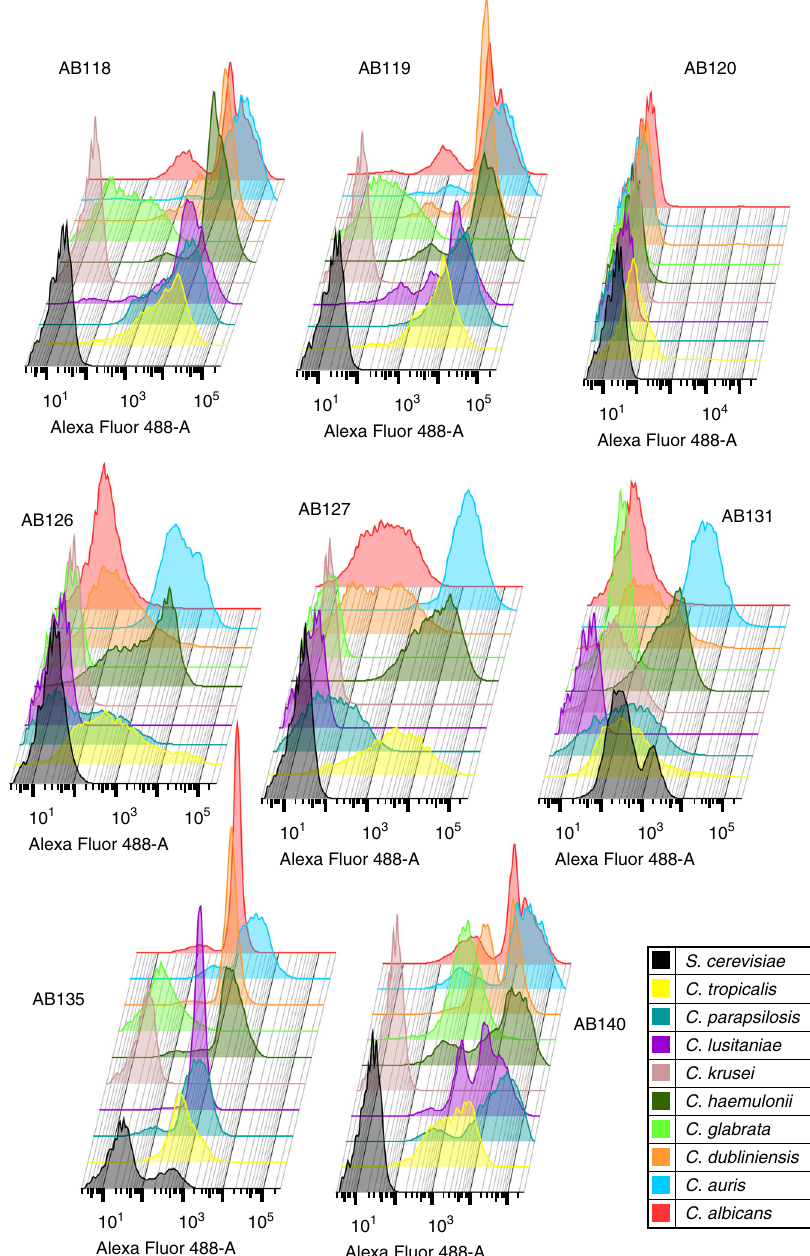
Fig. 6 Anti- Candida mAbs binding pro fi les to clinically relevant Candida species and S . cerevisiae . Representative FACS data from three separate experiments of anti- Candida mAbs (one mAb from each clonal cluster) binding to different species shown as histograms. Data were obtained using a BD Fortessa fl ow